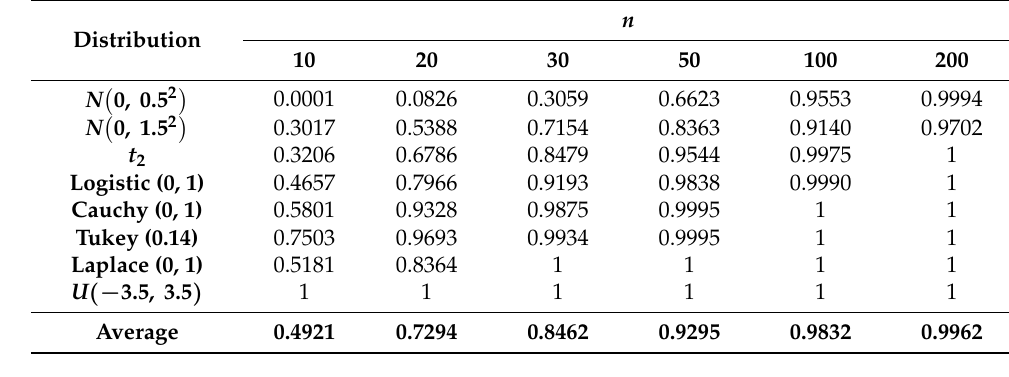
Table 3. Empirical powers of statistic 𝑉(cid:3364) (cid:3041) for asymmetric alternative distributions for the level of significance 𝛼 = 0.05 . Distribution